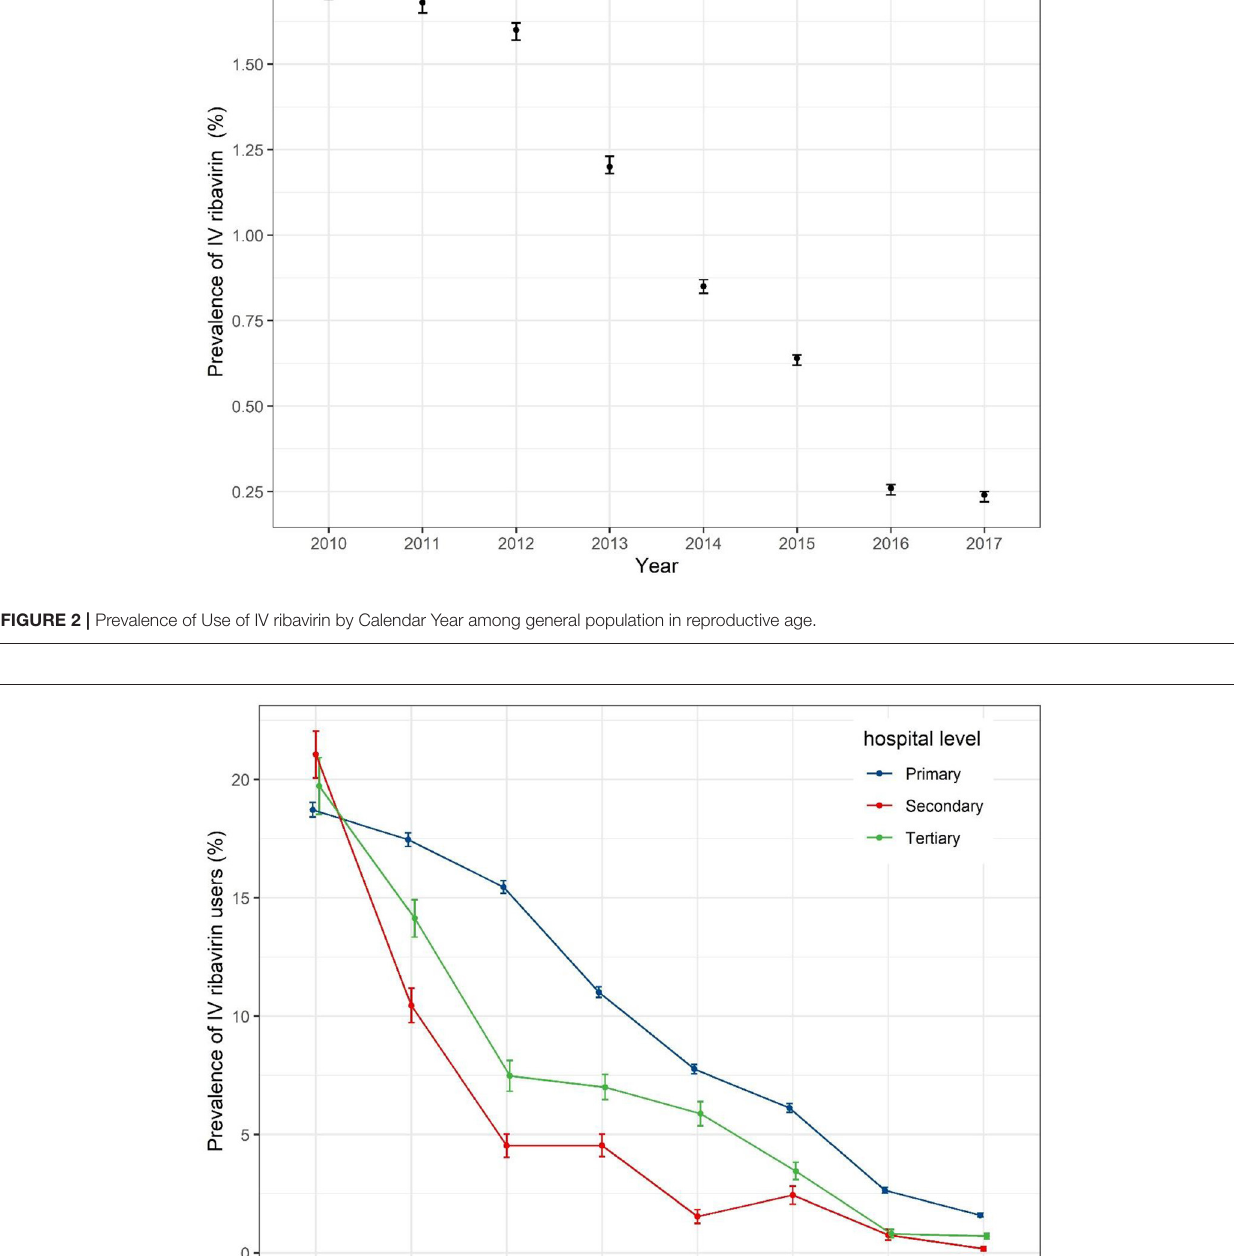
The annual prevalence of IV ribavirin users decreased from 1.72% in 2010 to 0.24% in 2017 ( P < 0.001). A general decrease of prevalence of IV ribavirin were found in different